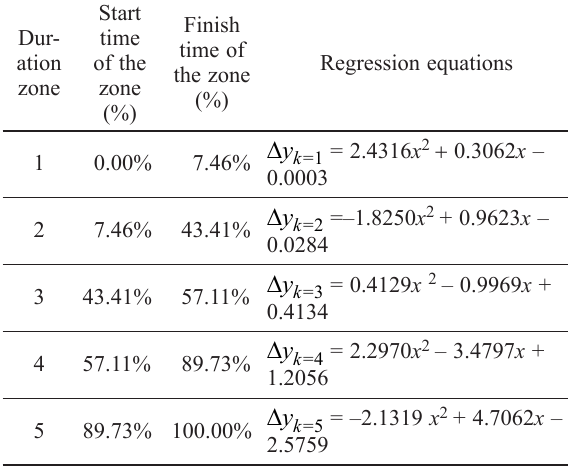
Table 8. Regression equations to calculate the